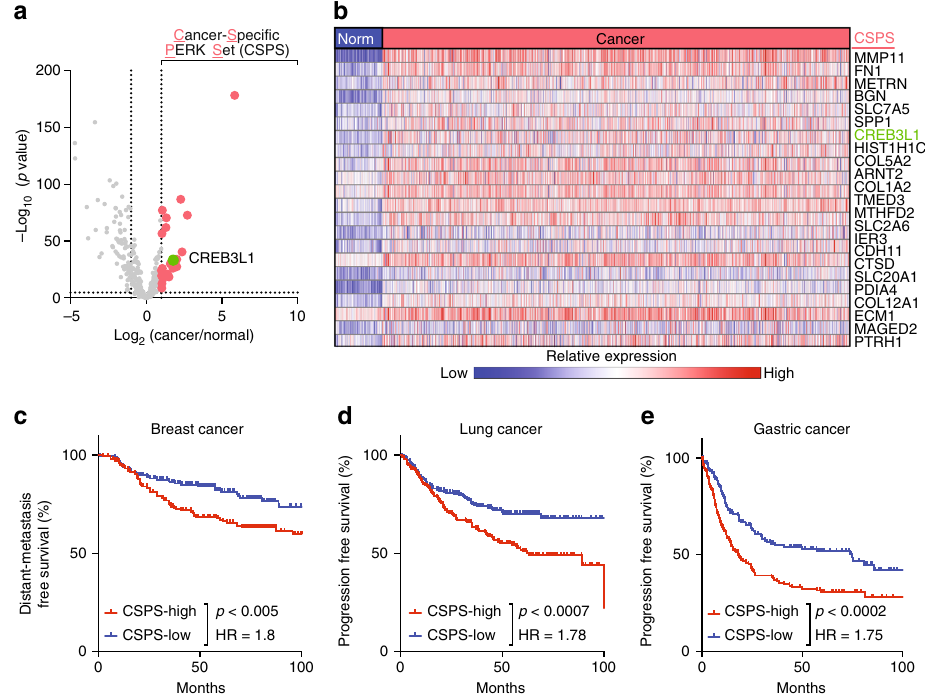
Fig. 1 Cancer-speci fi c PERK signaling correlates with progression and metastasis. a A volcano plot comparing the expression of 388 PERK pathway genes between breast cancer tissues and normal breast tissues. Plotted for each gene are the negative log 10 of the p value and the log 2 of the fold change of gene expression of cancer samples relative to normal samples. A set of 23 genes that are twofold overexpressed in cancer and signi fi cant after Bonferroni correction were de fi ned as the cancer-speci fi c PERK set (CSPS; red dots). b A heat map showing the expression of the CSPS genes across 112 normal breast samples and 1093 breast tumors. c – e Average expression of CSPS genes was used to examine survival in breast, lung, and gastric tumor data sets. Patients were binned into CSPS high (top tertile) and CSPS low (bottom tertile), and survival curves were plotted. A cohort of c breast cancers was analyzed for metastasis-free survival (GSE17907, GSE9195, GSE20685, GSE16446, and GSE19615, n = 182 for each arm). A cohort of d lung cancers and e gastric cancers were analyzed for progression-free survival (lung cancer: GSE8894, GSE50081, GSE29013, and GSE31210, n = 195 for each arm; gastric cancer: GSE22377, GSE15459, and GSE62254, n = 167 for each arm). The indicated p -values were calculated using the log-rank